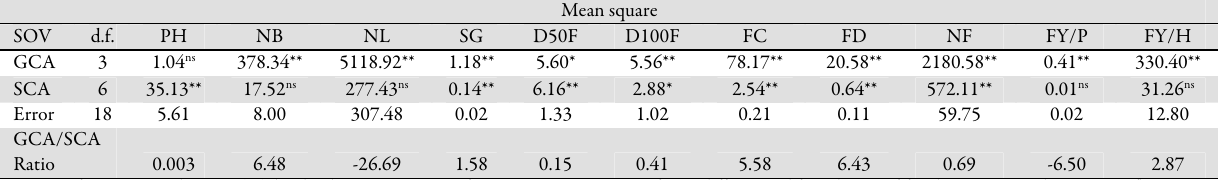
Table 3. Analysis of variance for combining ability on the agronomic traits of genitors and F 1 hybrid of eggplant genotypes